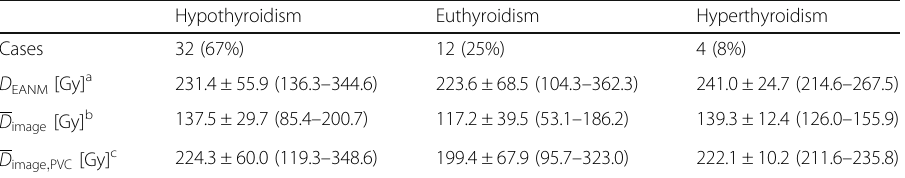
Table 2 Relationship between therapeutic outcomes and thyroid-absorbed dose calculated from each method Hypothyroidism Euthyroidism